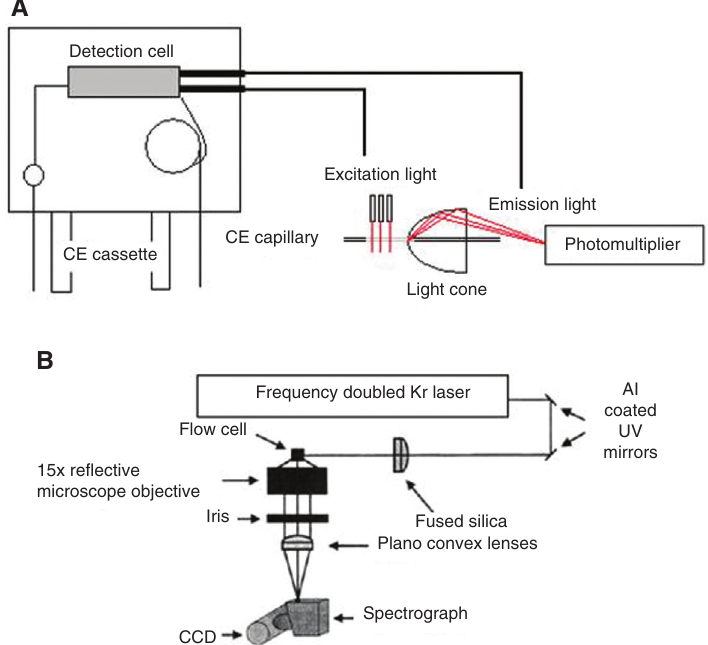
Figure 4 Scheme of FD designs coupled to on-capillary (A) and to end-capillary (B) modes with commercially available CE equipment. Part (B) was reprinted with permission from Timperman et al. 1995a,b. Copyright 2014 American Chemical